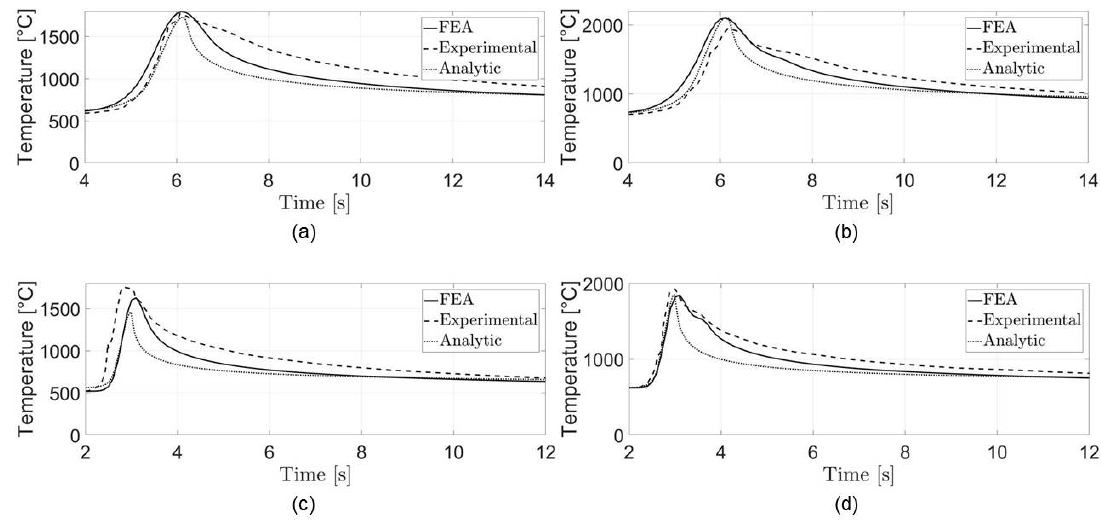
Figure 3. Comparison of the surface temperature. ( a ) P = 400 W, V = 0.2 m/min; ( b ) P = 600 W, V = 0.2 m/min; ( c ) P = 400 W, V = 0.4 m/min; ( d ) P = 600 W, V = 0.4 m/min.